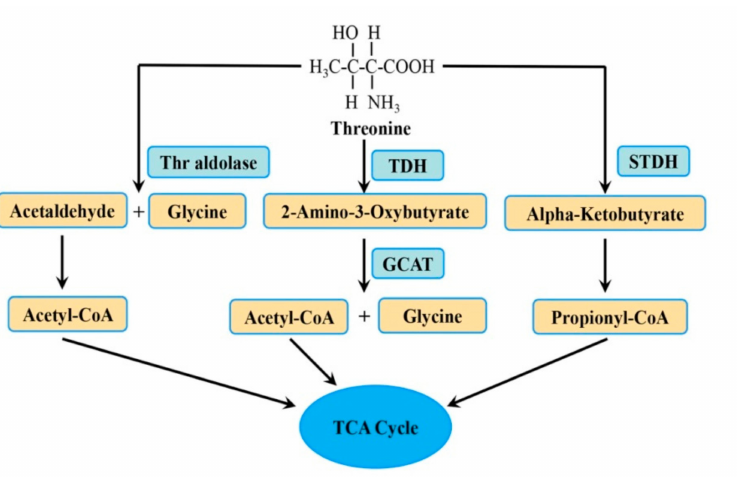
Figure 1. The metabolic pathway of Thr. Thr is metabolized to different intermediates and end products by three enzymes. Abbreviations: GCAT: 2-amino-3-oxobutyrate CoA ligase; STDH: threonine dehydratase; TCA: tricarboxylic acid cycle; TDH: threonine dehydrogenase; Thr: